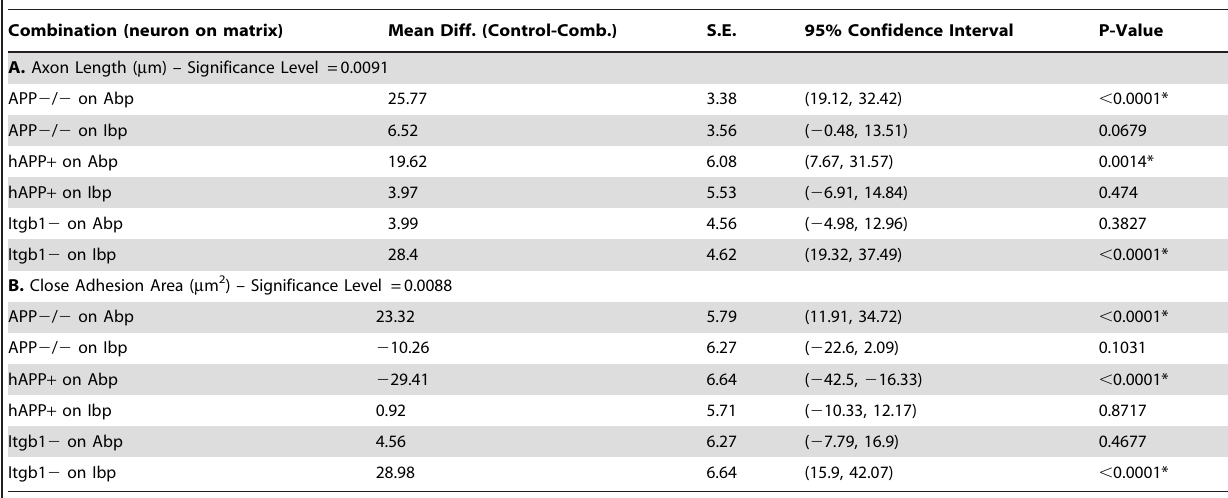
Table 5. GCs on Synthetic Matrices – Statistical